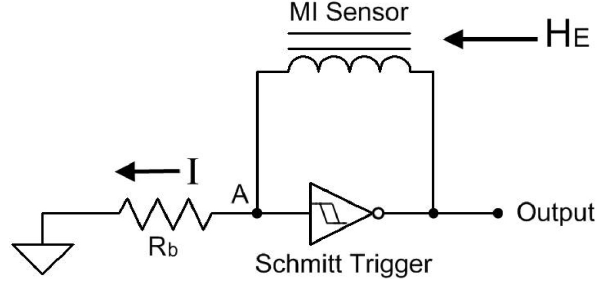
Figure 1. Basic circuit showing the working principle of the magneto-inductive technology. The Schmitt trigger flips the direc- tion of the current that causes the sensor to charge and discharge in both directions (from Leuzinger and Taylor,